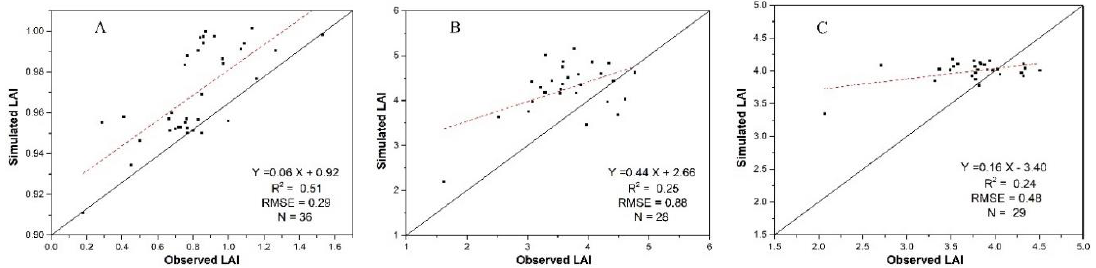
Figure 7. The LAI estimation accuracies for the calibrated WOFOST model ( A ) 30 June, ( B ) 29 July, ( C ) 25 August.